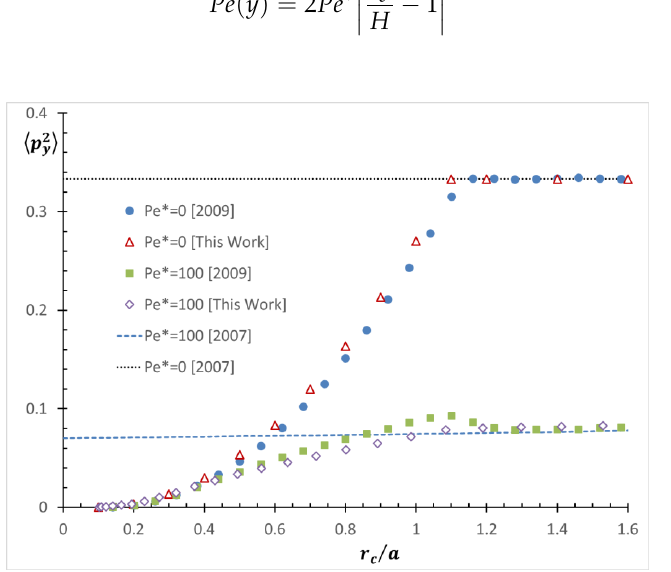
Figure 16. The < p y2 > profile as a function of r c / a for a shear flow in a channel with H = 12 a . Predictions from this work [open symbols], from the previous model [lines] by Park et al. (2007) [25] and the previous simulation results [solid symbols] by Park and Butler (2009) [24] are compared. Note that the half rod length distance from a wall is at 1.1 a due to the rod diameter. The small discrepancy between the previous bulk values at r c > 1.1 a and the values from this work are from the